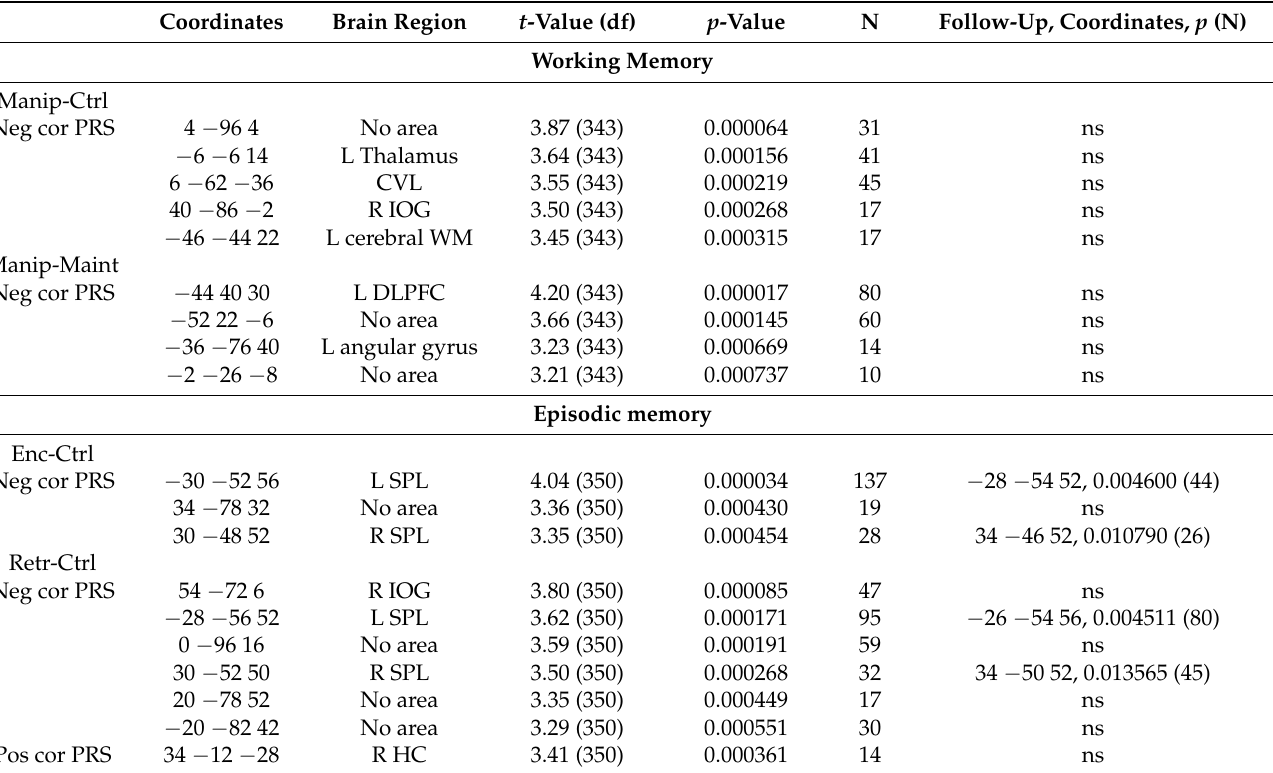
Table 3. Peak values of activation associated with polygenic risk for schizophrenia during working memory and episodic memory ( p -value threshold: 0.001, voxel threshold: 10) from whole-brain analyses at baseline and ROI analyses at follow-up ( p -value threshold: 0.05). N = number of voxels. Coordinates Brain Region t -Value (df) p -Value N Follow-Up, Coordinates, p (N) Working